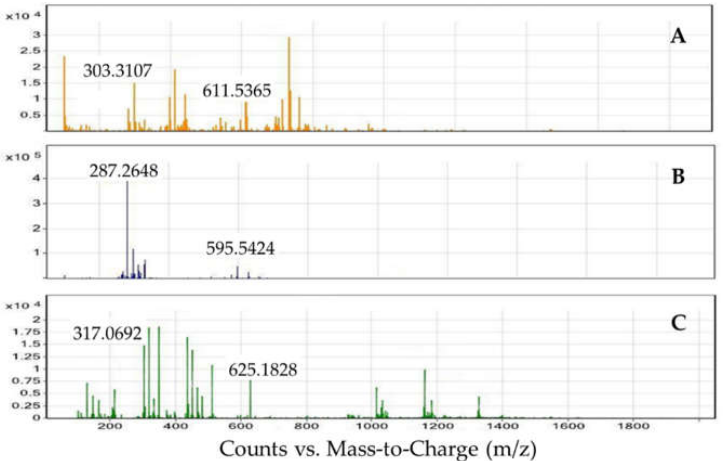
Figure 3. MS/MS spectrum scan of 3 identified minor anthocyanins in unfiltered rabbiteye blueberry juice: delphinidin-3-(p-coumaroyl-glucoside), top plate ( A ); cyanidin-3-(p-coumaroyl-glucoside), middle plate ( B ) and petunidin-3-(p-coumaroyl-glucoside) bottom plate ( C ).